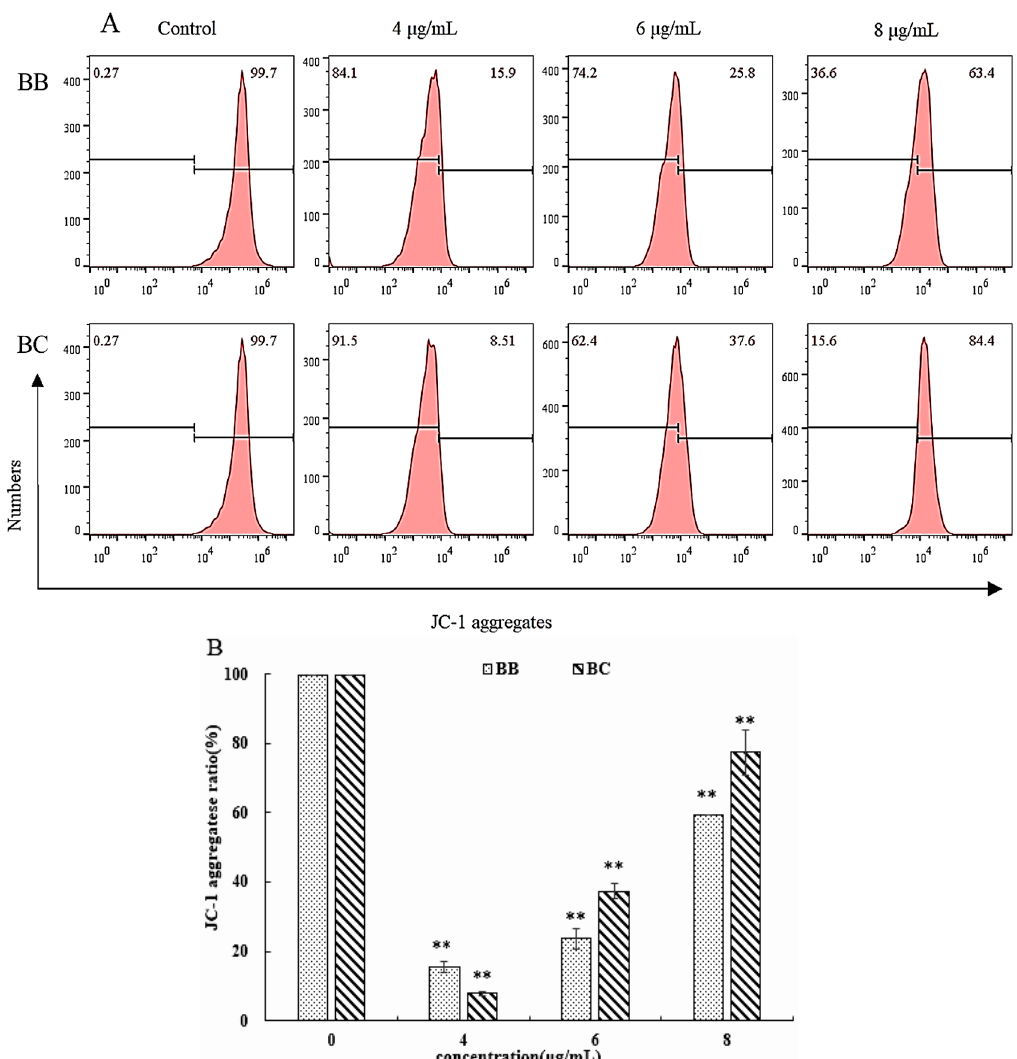
Figure 8. Effect of BB and BC on the mitochondrial membrane potential of BGC-823 cells (( A ) JC-1 monochrome flow chart; ( B ) JC-1 positive aggregate statistical chart; ** p < 0.01).